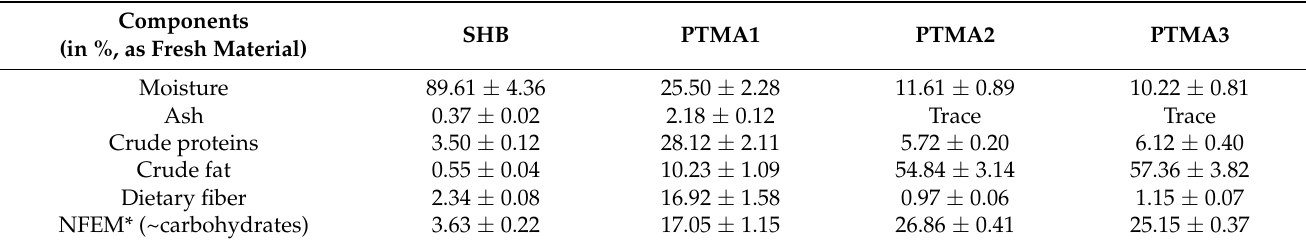
Table 1. Proximate analysis of selected herbs (SHB) and the final products (PTMAs) (±standard errors of the mean of four replicate experiments).